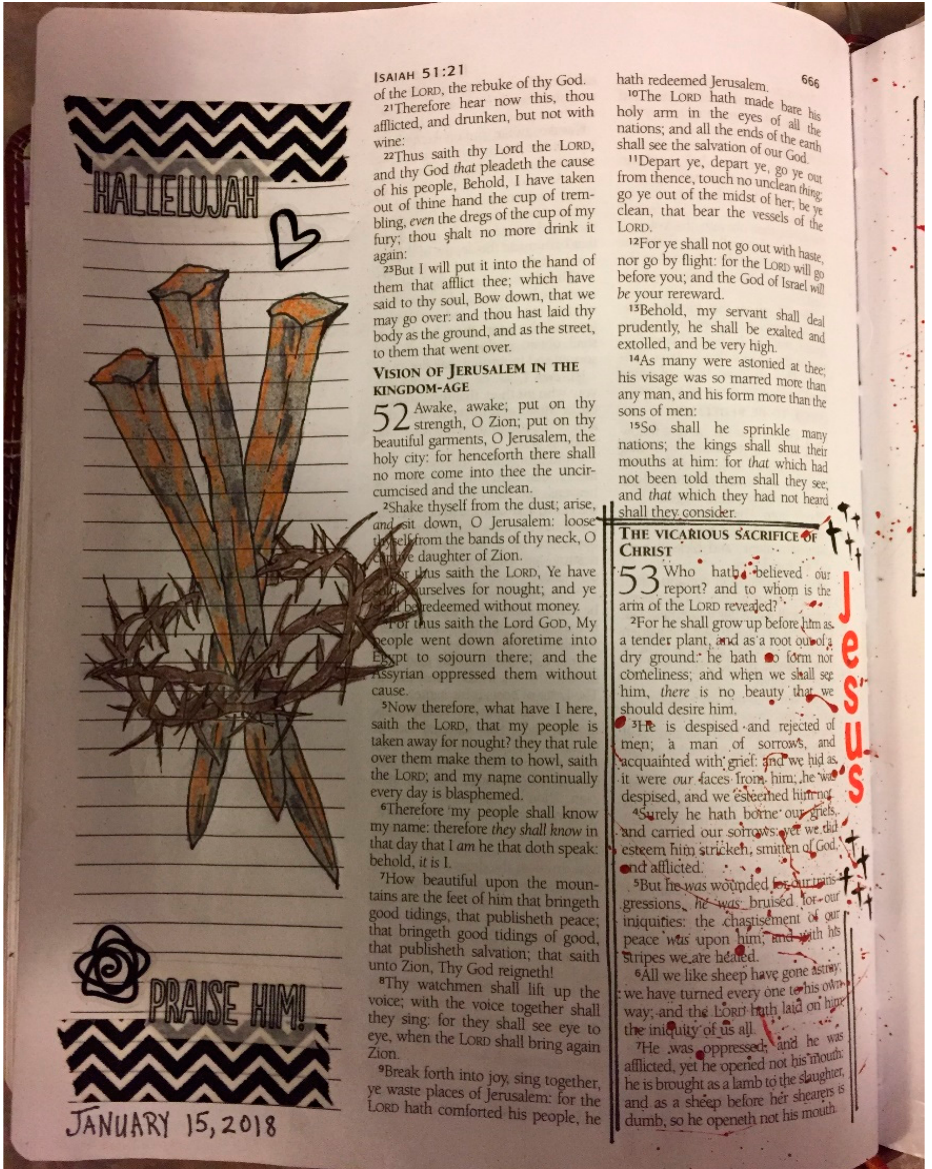
Figure 4. “Isaiah 53” (2018), Anonymous (Pinterest). It is pertinent to note here the erroneous,